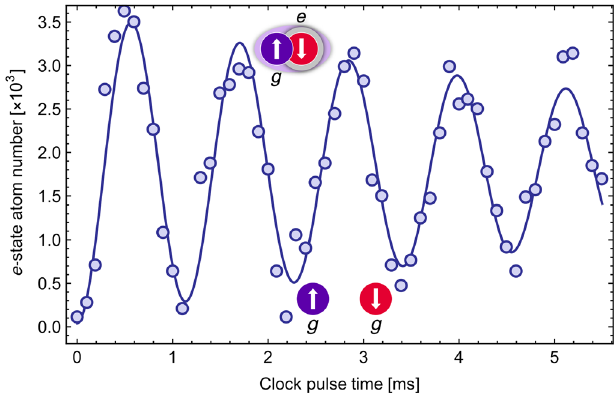
FIG. 4. Rabi oscillation on a j g i − j e i photoassociation peak performed at a magnetic field B ¼ 150 G and 3D lattice depth ¼ 30 . The points are the experimental data and the solid curve s f is a fit with a damped sinusoidal function with a decay time constant of 7.5(1.6) ms. Several periods of photoassociation and photodissociation cycles can be observed. No error bars are present since every point is the result of a single